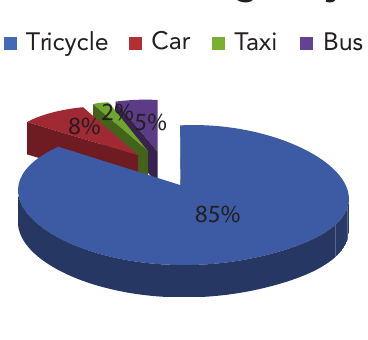
Figure 2: Customers’